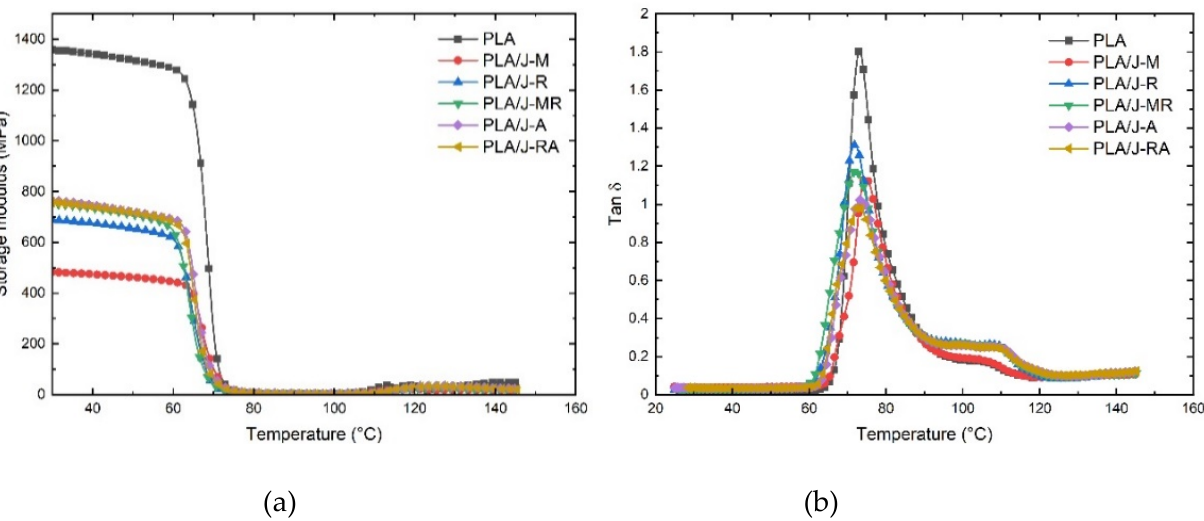
Figure 4. Photographs of the failure surface corresponding to: ( a ) PLA/J-M, ( b ) PLA/J-RA. All specimens failed similarly. DMA provides relevant information on the viscoelastic behavior of polymers and composites. Storage modulus measures stress stored in the specimens as mechanical energy, while the damping factor is a typical measure of energy dissipation. DMA curves corresponding to storage modulus and damping factor are presented in Figure 5.